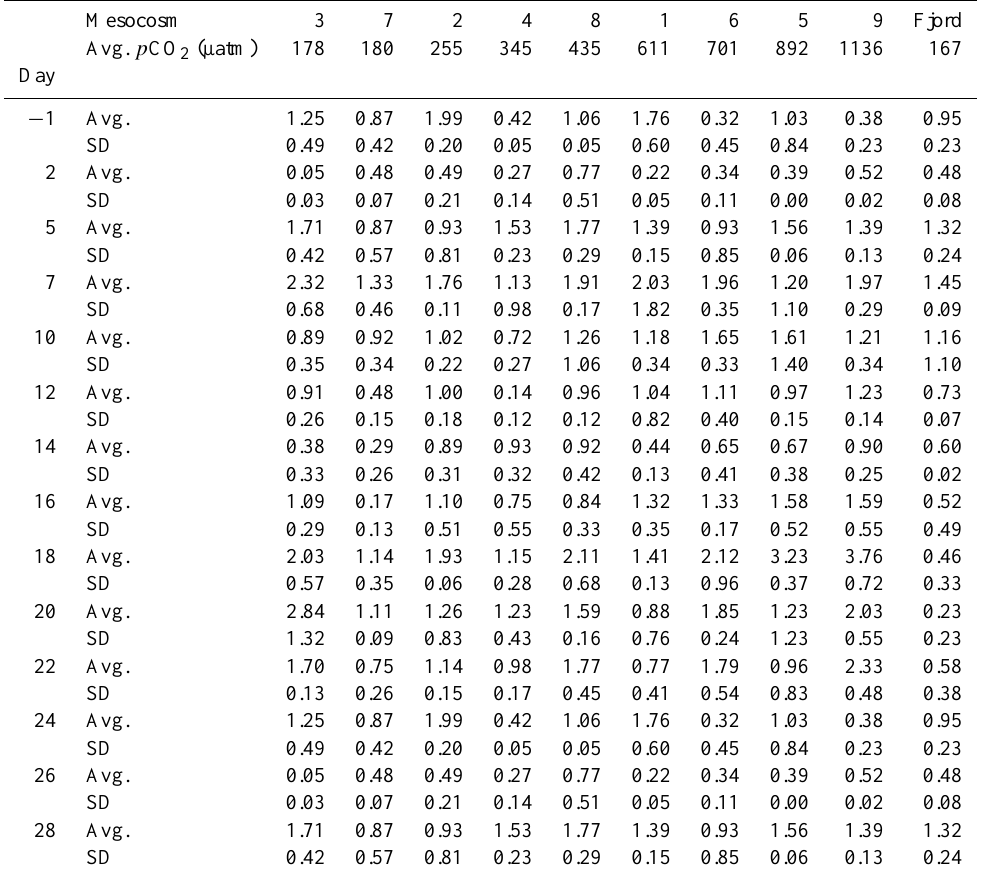
Table 3. Production (µmolCL − 1 d − 1 ) of dissolved organic carbon (DOC), based on 14 C bottle incubations. Averages (Avg.) and standard deviations (SD) were calculated from on triplicate measurements of 24h